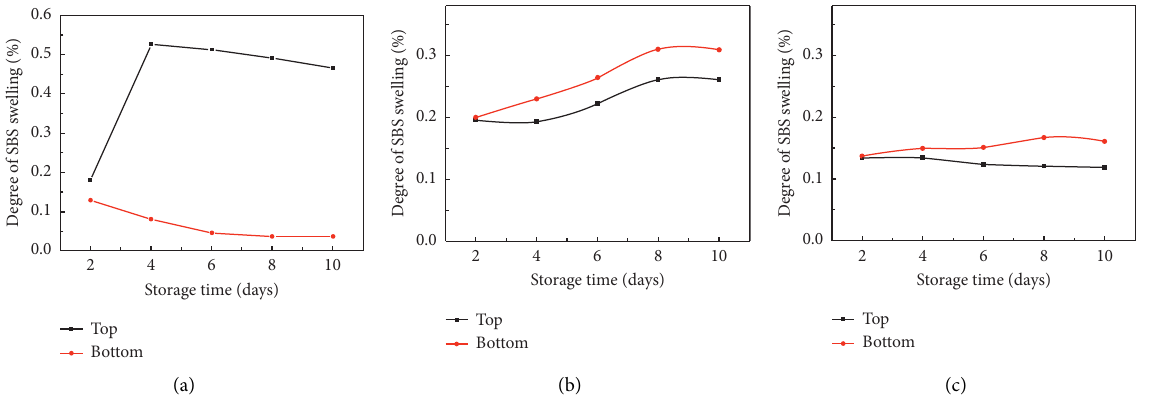
Figure 15: Degree of SBS swelling of three modified asphalt samples with different separation times. The samples of (a) SBSMA, (b) SBS+CNTs-I, and (c) SBS+CNTs-II.